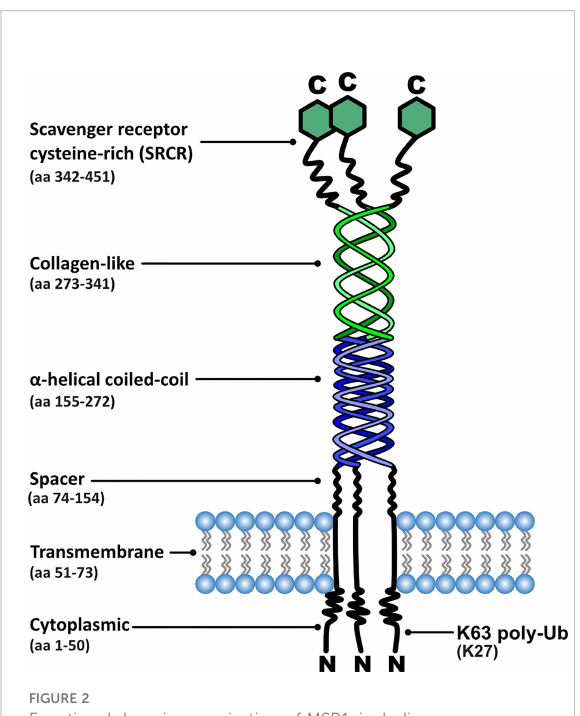
FIGURE 2 Functional domain organisation of MSR1, including corresponding amino acid (aa) positions and post-translational modi fi cation sites relevant to